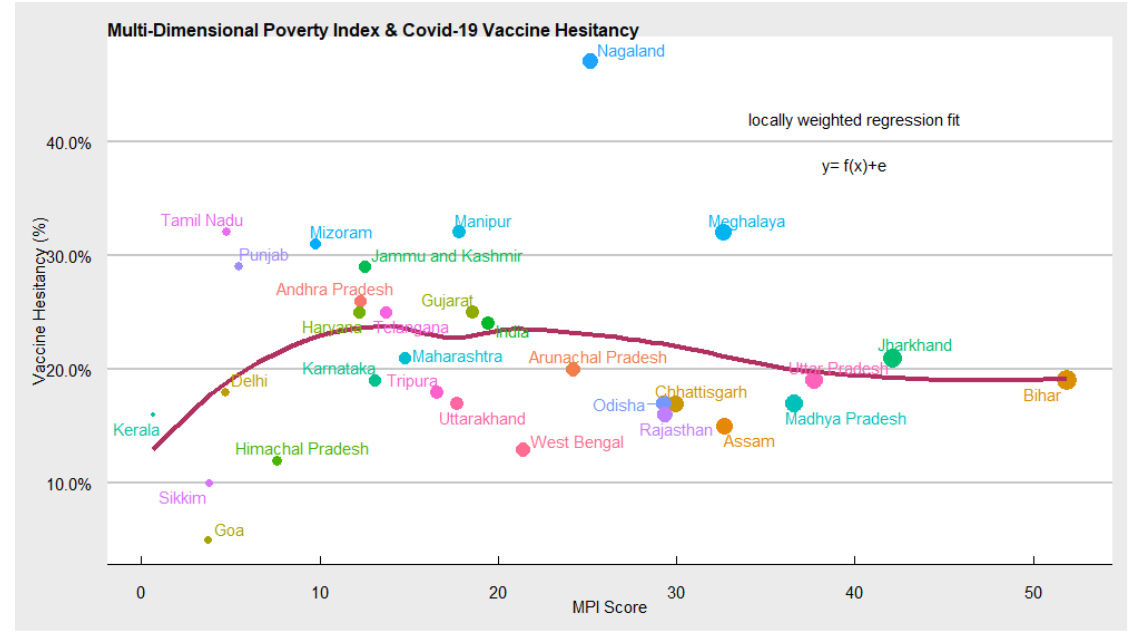
Figure 10. Results of vaccine hesitancy and MPI.